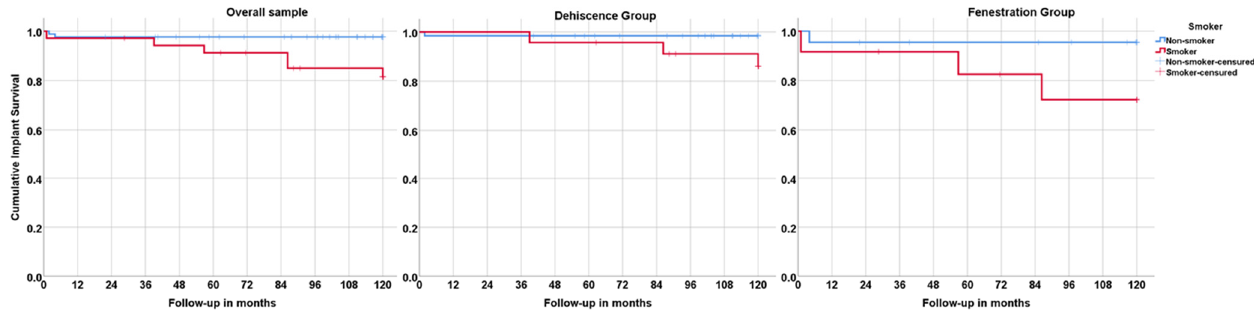
Figure 4. Graphical illustration of the cumulative implant survival estimation using the patient as the unit of analysis. Note the significant negative influence of smoking habits on implant survival overall and in both groups.